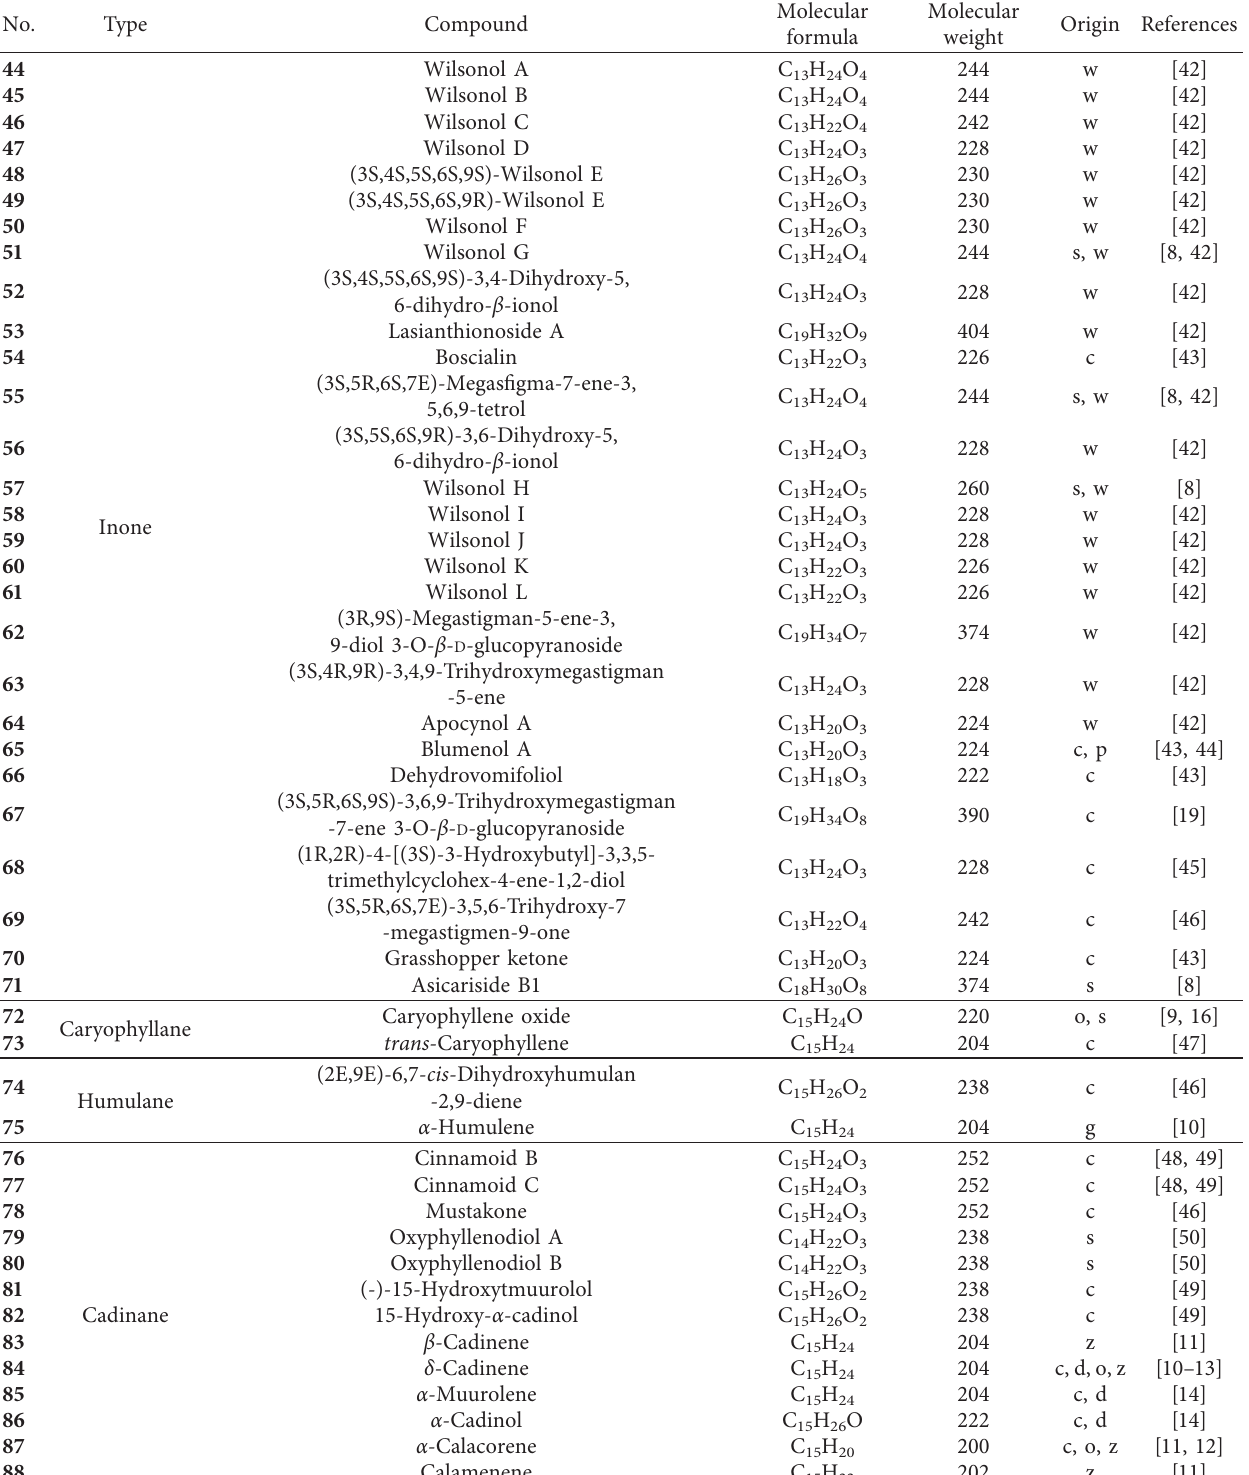
Table 2: Sesquiterpenes from the genus Cinnamomum .